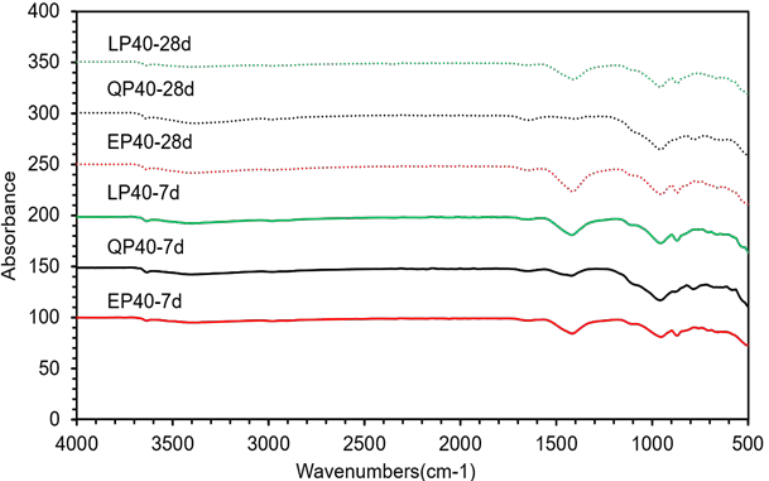
Figure 16. Fourier transform infrared spectroscopy analysis (FTIR) of EP40, QP40 and